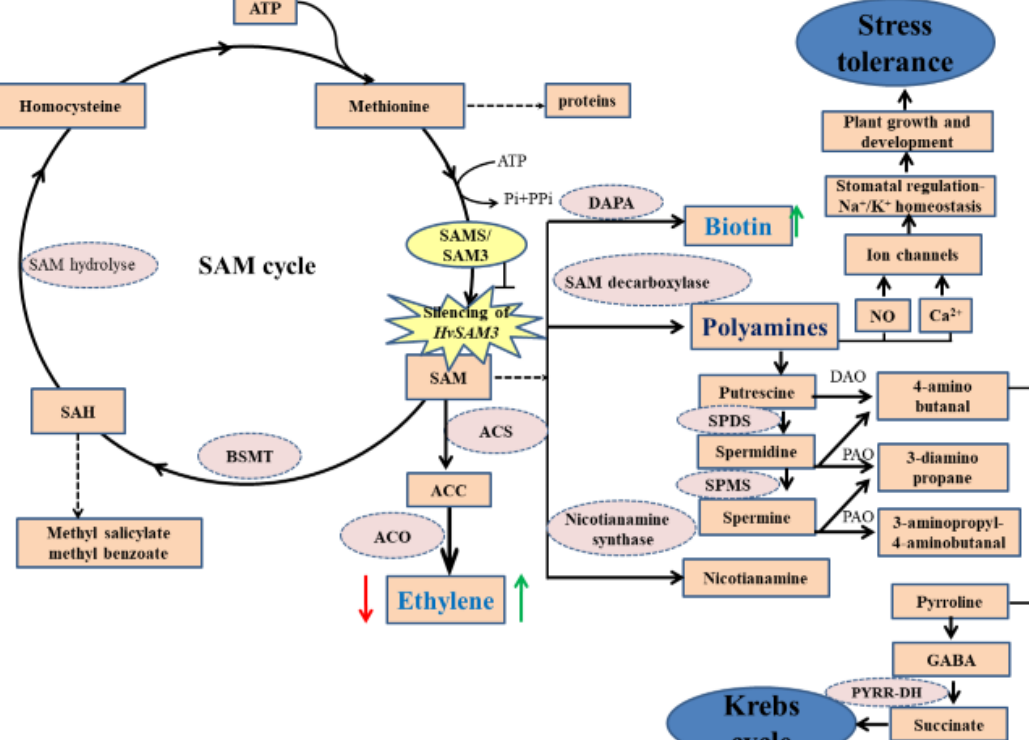
Figure 7. A proposed model for HvSAMS3 improvement of plant growth and development regulated by biotin and ethylene in wild barley XZ5. HvSAMS3 silencing of SAM cycle involving in ethylene, polyamines, and biotin biosynthesis process in Tibetan barley plants. Silencing of HvSAMS3 decreases ethylene, putrescine, spermidine and spermine, polyamine oxidase, and antioxidant enzyme activities, whereas these e ff ects were alleviated by exogenous ethylene and biotin under combined stress. Thick arrows indicate up- and downregulated changes. Dashed arrows indicate multiple steps, the blunted arrow indicates the silence e ff ect of HvSAMS3 . Thick red arrows mark the e ff ect of the BSMV:HvSAMS3, and thick green arrows mark relative changes by exogenous ethylene and biotin under combined drought and salinity stress. SAM: S-Adenosyl-L-methionine; SAMS: S-Adenosyl-L-methionine